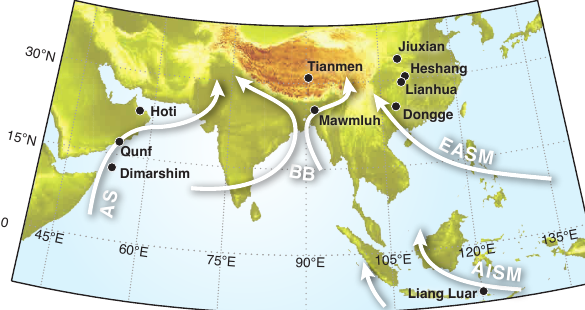
Figure 1. Map of southern Asia showing the main flow directions of moist air masses associated with different monsoon branches: Arabian Sea (AS) and Bay of Bengal (BB) branches of the In- dian summer monsoon, East Asian summer monsoon (EASM), and Australian–Indonesian summer monsoon (AISM). Furthermore, the locations of the caves where the speleothem records used in this work have been obtained from are displayed (see Table